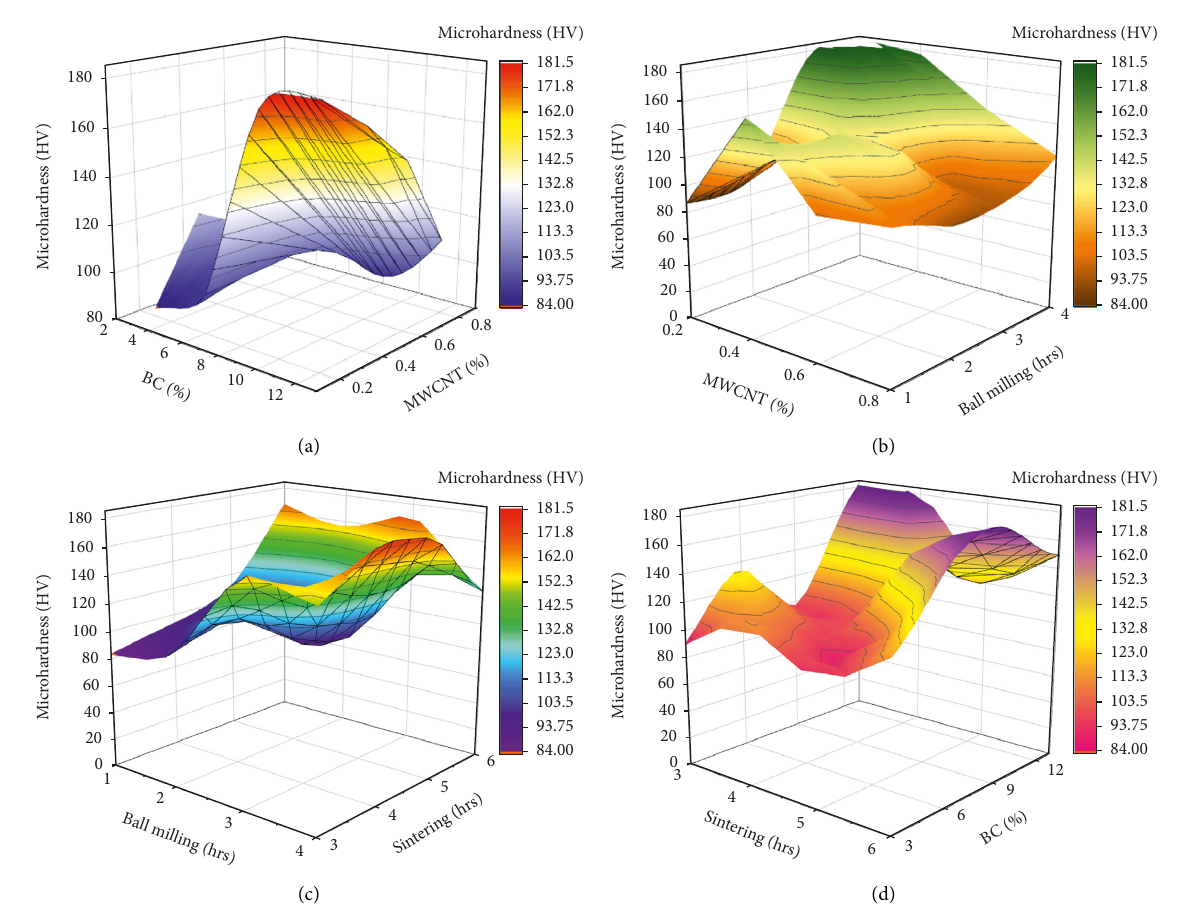
4 C % vs. MWCNT (%); (b) MWCNT (%) vs. ball milling; (c) ball milling vs.